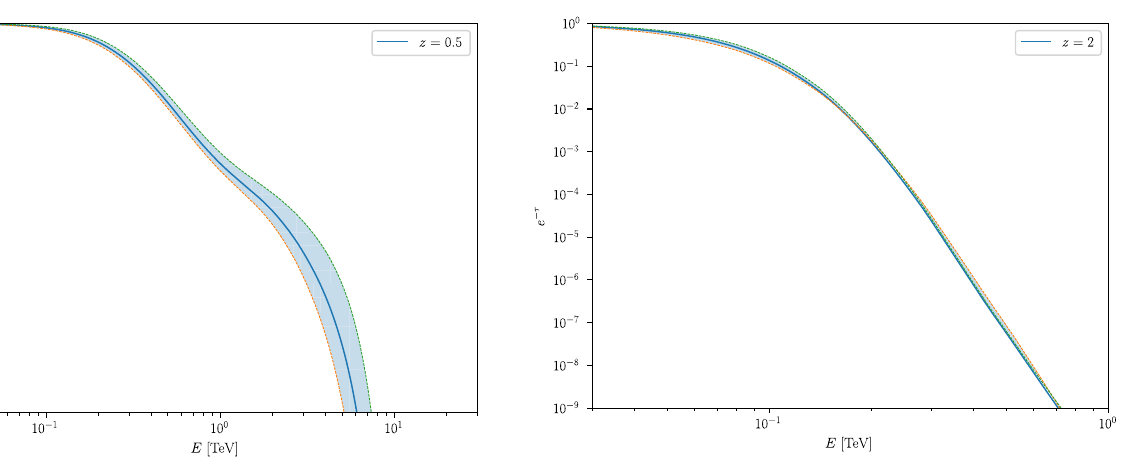
Fig. 6 The EBL attenuation ( e − τ ) of photons from a source with red- shift z = 0 . 5. The model and data are taken from Ref. [50] and http:// side.iaa.es/EBL/